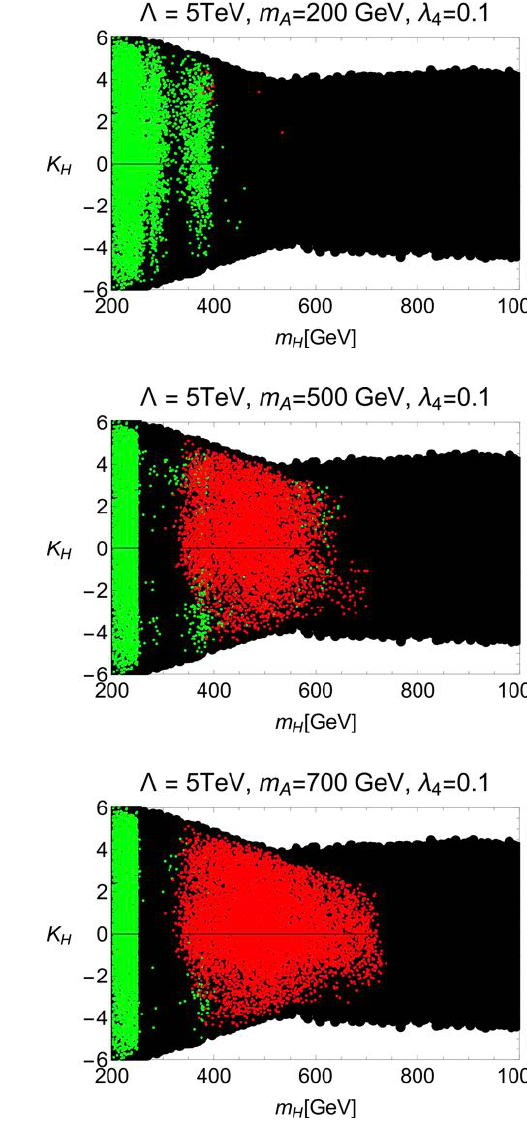
Figure 9 . Scatter plots of the amount of mixing between the heavy Higgs and the radion, K H de(cid:12)ned in equation (3.6), as function of the heavy Higgs mass for the type-I 2HDM. The black region is theoretically allowed and the points colored yellow, green and red are forbidden by heavy scalar searches in the WW , ZZ and hh channels respectively. The benchmark point (cid:3) = 3(5)TeV was used on the left (right). Due to the custodial symmetry, the charged scalar mass is identical to the pseudoscalar mass, whose value is given above each (cid:12)gure. The radion mass, m r , is varied from 200 to 1000